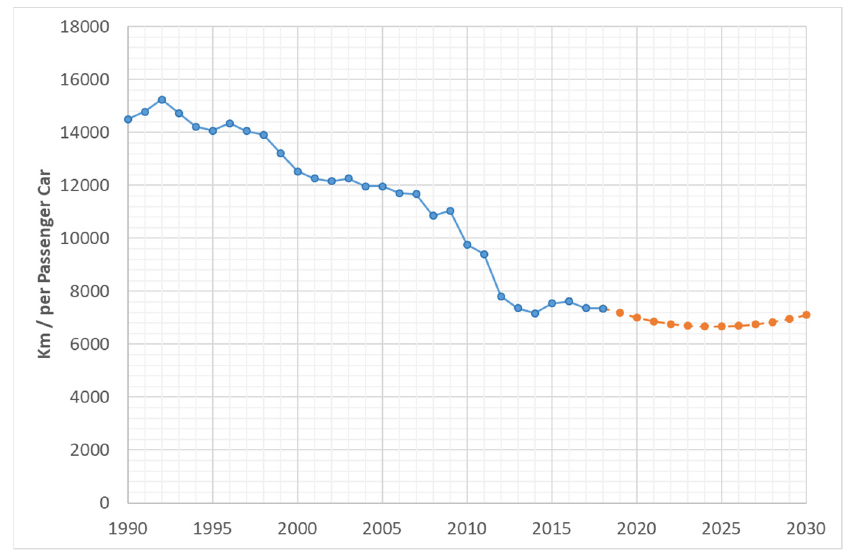
Figure 11. Average annual distance travelled (Km) in Greece by passenger vehicles, from 1990 to